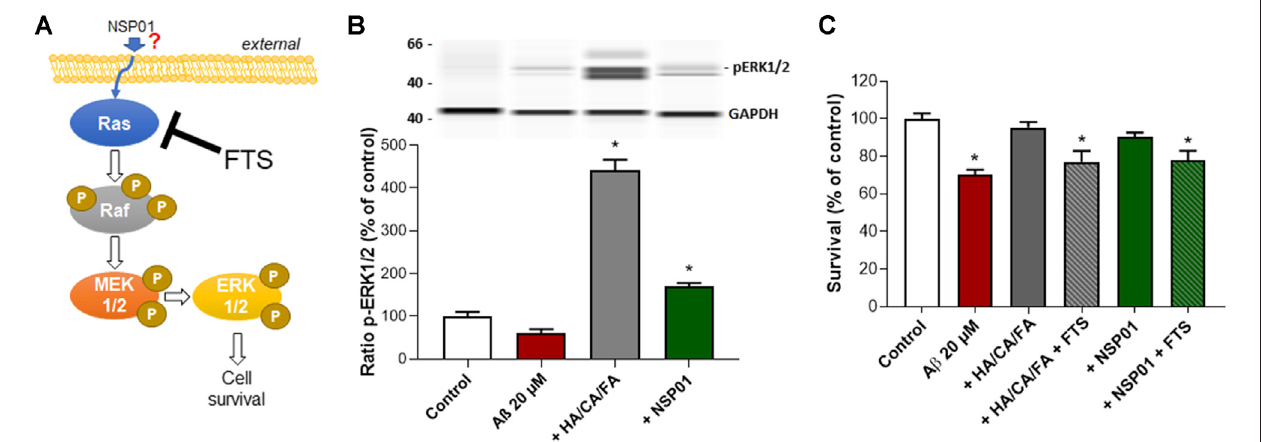
FIGURE5| InhibitionofRaspathwaypreventNSP01orHA/CA/FAneuroprotection. (A) ,schematicrepresentationofRas/Raf/MEK/ERK1/2pathwayandFTSsite ofaction. Brie fl y,growthfactorsormitogensleadtotheactivationofspeci fi creceptorsontheplasmamembranewhichinturntransmittheactivatingsignalstoRas.Ras interacts and phosphorylates a wide range of downstream effector proteins, including Raf proteins (isoforms of the serine/threonine kinase). MEK1/2 is then phosphorylated at two serine residues and subsequently phosphorylates ERK1/2 on both threonine and tyrosine. Activated ERK1/2 proteins translocate to the nucleus where they activate multiple transcription factors causing changes in cell proliferation and survival. (B) , WB of ERK1/2 phosphorylation normalized to GAPDH. (C) ,quanti fi cationofMAP-2stainingincorticalneuronsexposedto20 µMofA β andtreatedwithNSP01(25 μ g/ml)orHA1pM+CA500pM+FA10 nMmixturewithor without FTS (4 µM). All values are expressed as mean ± SEM (standard error of the mean). * p < 0.05 vs. control.